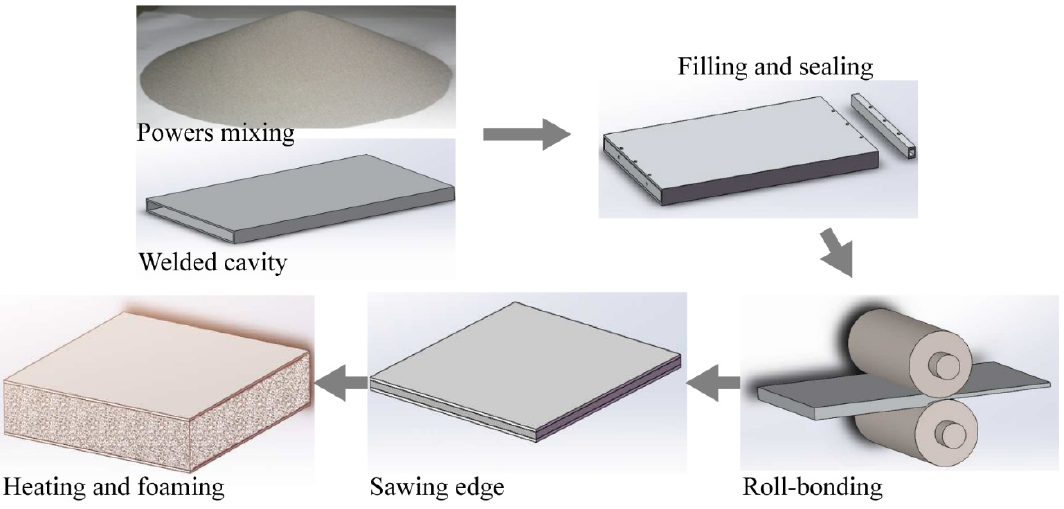
Figure 1. Process flow chart for preparation of